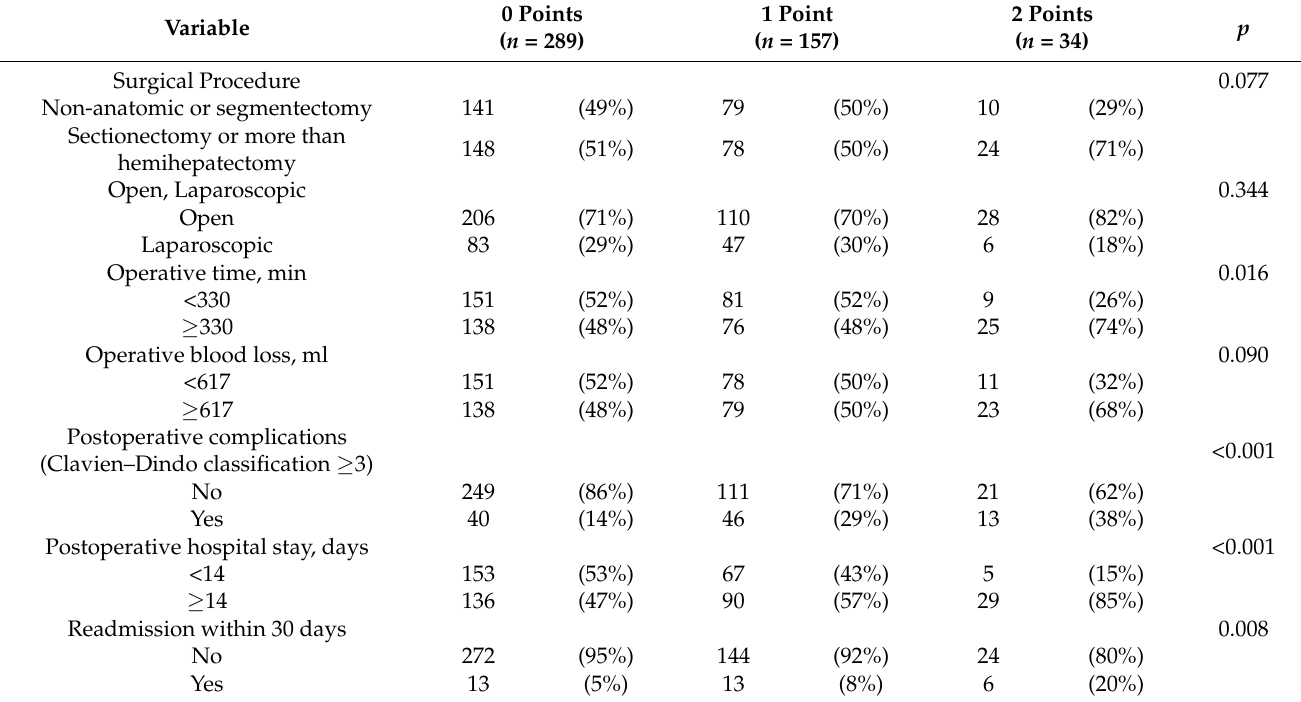
Table 2. Perioperative characteristics of 480 patients with hepatocellular carcinoma classified by mALF